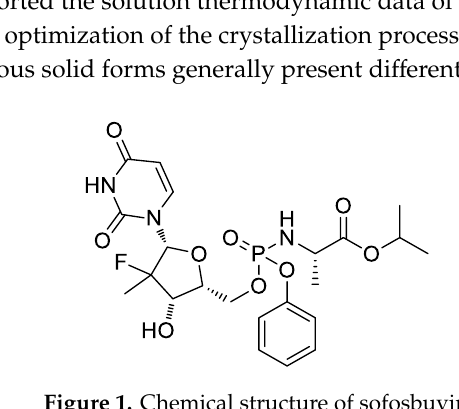
Figure 1. Chemical structure of sofosbuvir.